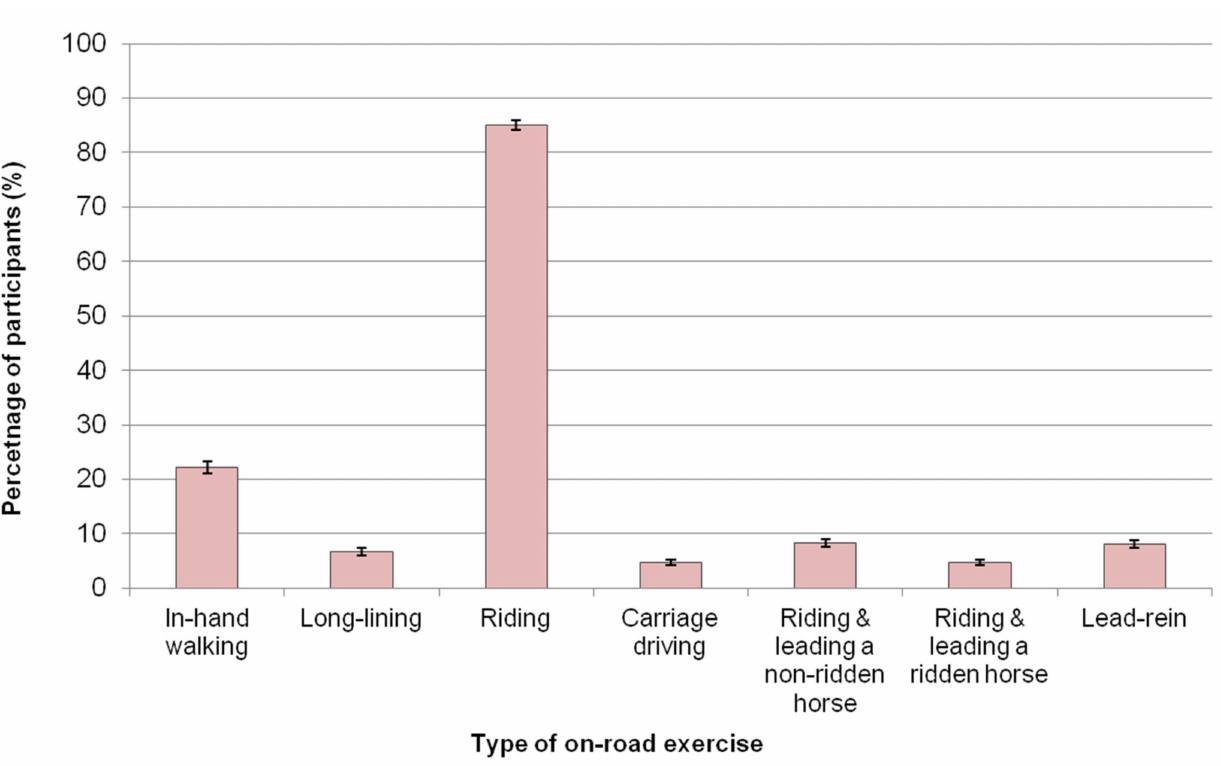
Figure 4. The types of on-road exercise UK equestrians ( n = 5426) reported doing with their horses at least once a week. Equestrians could select multiple exercise options; therefore, the exercise categories are not mutually exclusive. Error bars represent 95% confidence